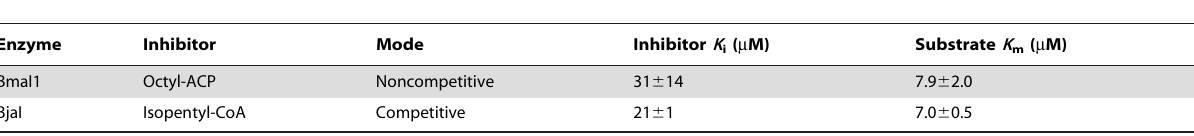
Table 2. Kinetics of inhibition by sulfide analogs.